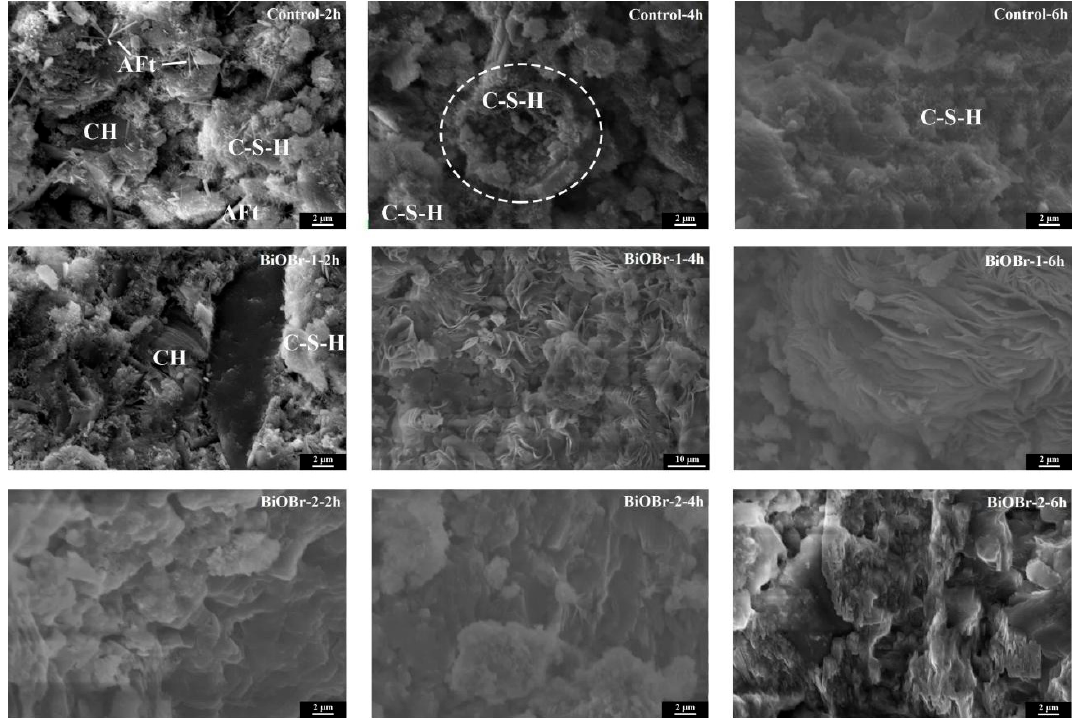
Figure 6. SEM images of hardened samples after autoclaved curing for different